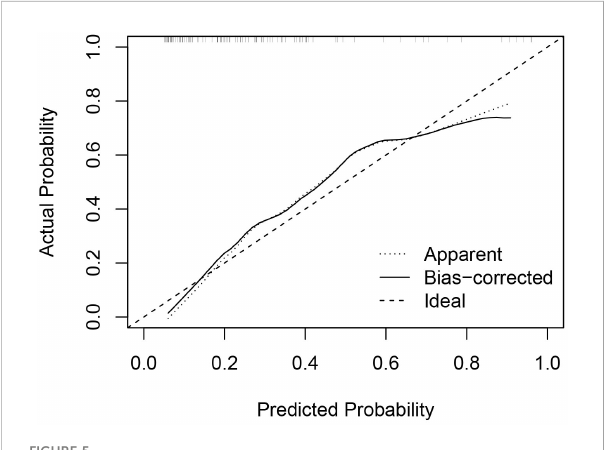
FIGURE 5 Calibration curve of the nomogram. The x axis represented the predicted probability of residue and the y axis represented the actual probability. The diagonal dashed line means an ideal model that can perfectly predict the residue. The solid line indicated the apparent predict performance of the